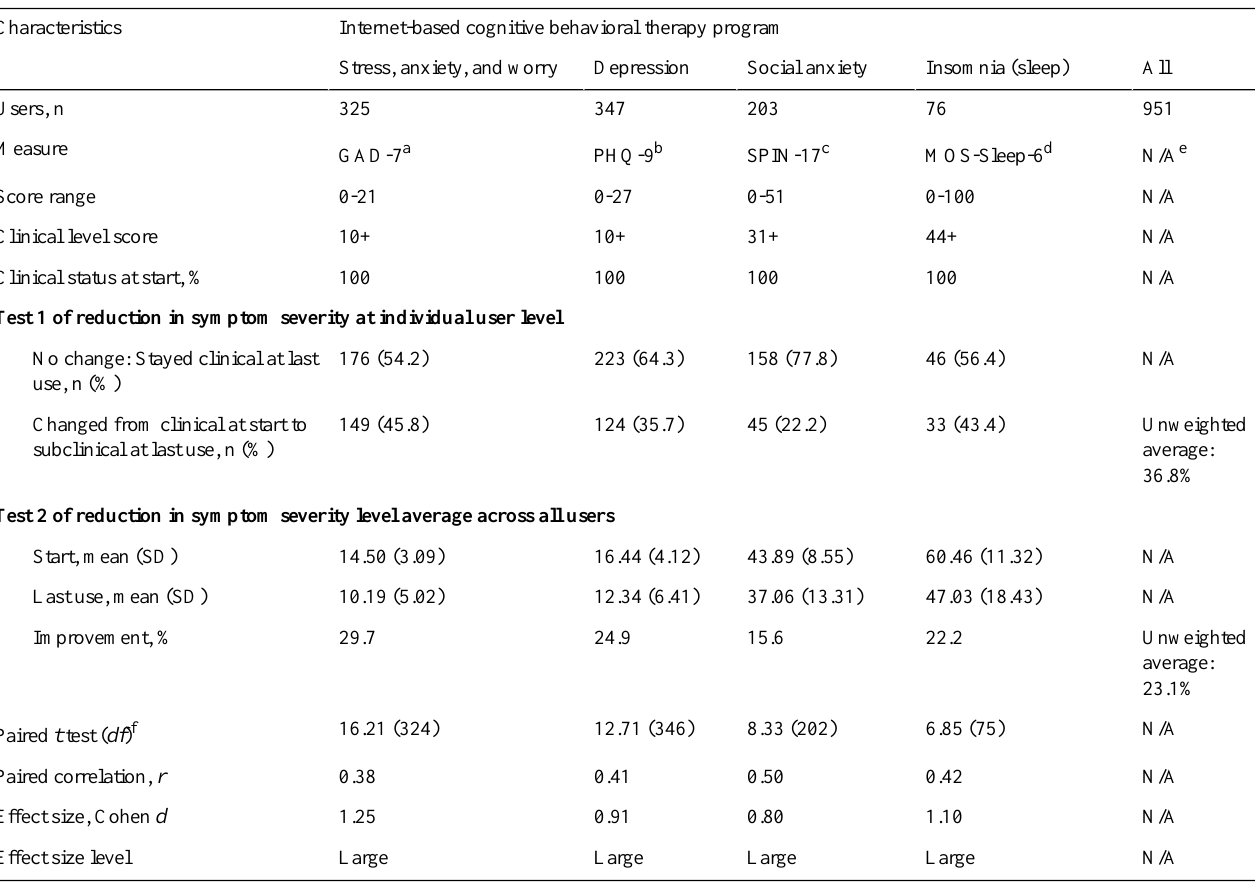
AllInsomnia (sleep)Social anxietyDepressionStress, anxiety, and worry